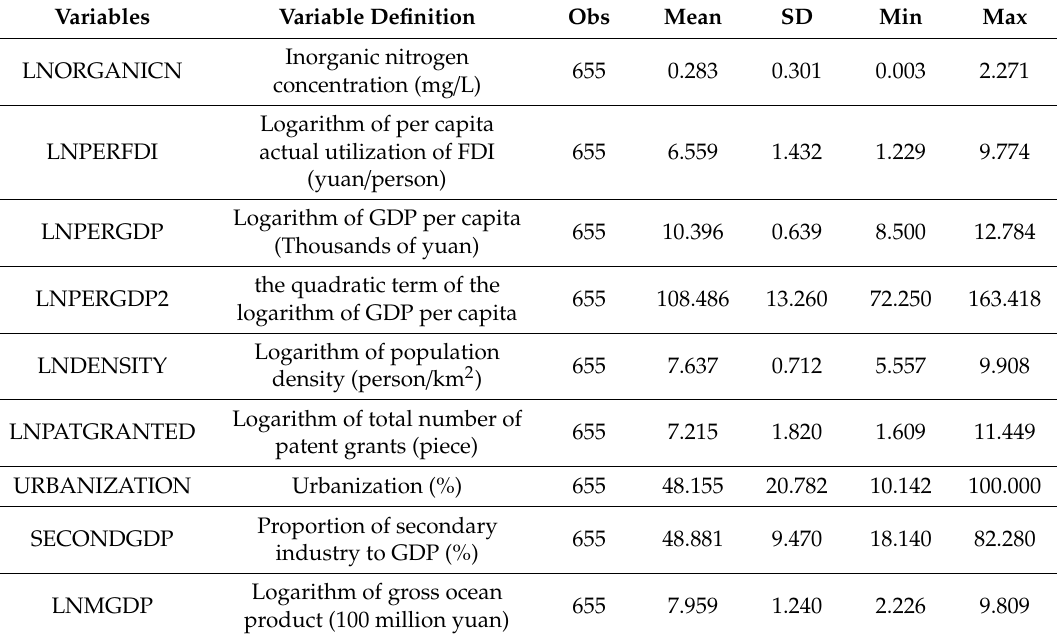
Table 1. Summary